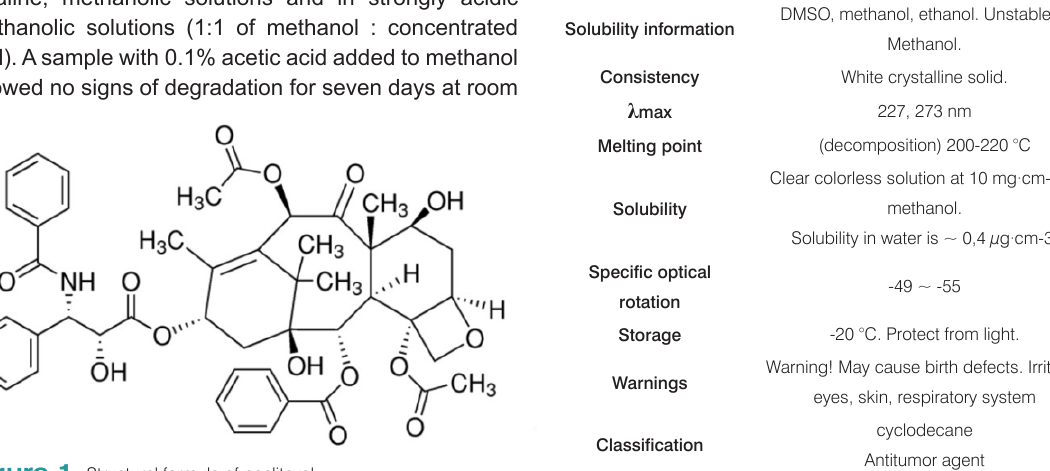
Figure 1. Structural formula of